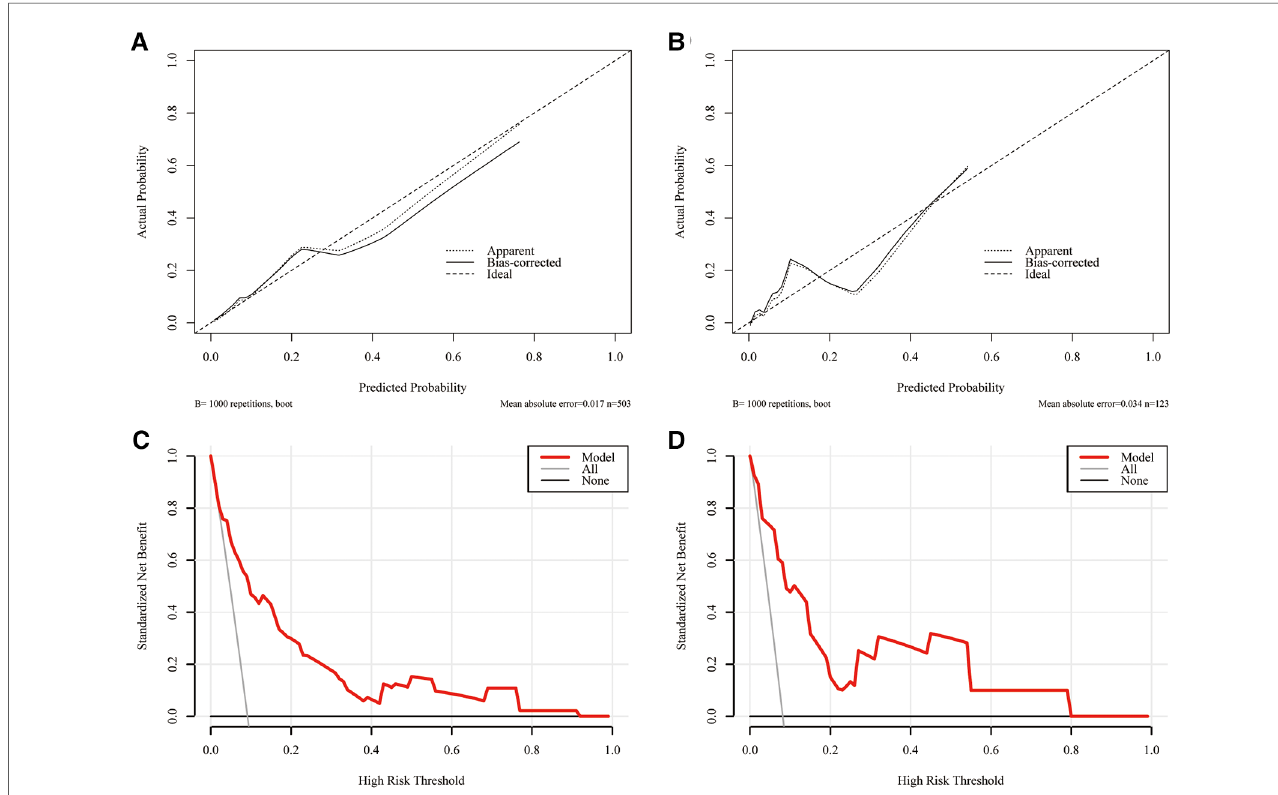
FIGURE 4 The calibration curves for comparing the predicted probabilities with actual probabilities and the DCA curves for estimating the net bene fi t of the prediction model. ( A ) The calibration curve in the training set; ( B ) the calibration curve in the validation set; ( C ) the DCA curve in the training set; ( D ) the DCA curve in the validation